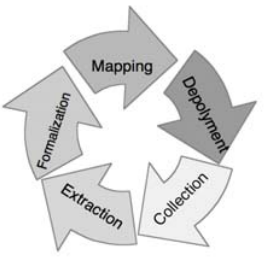
Figure 1. A proposed ontology-based process to bridge the semantic gaps between GI and